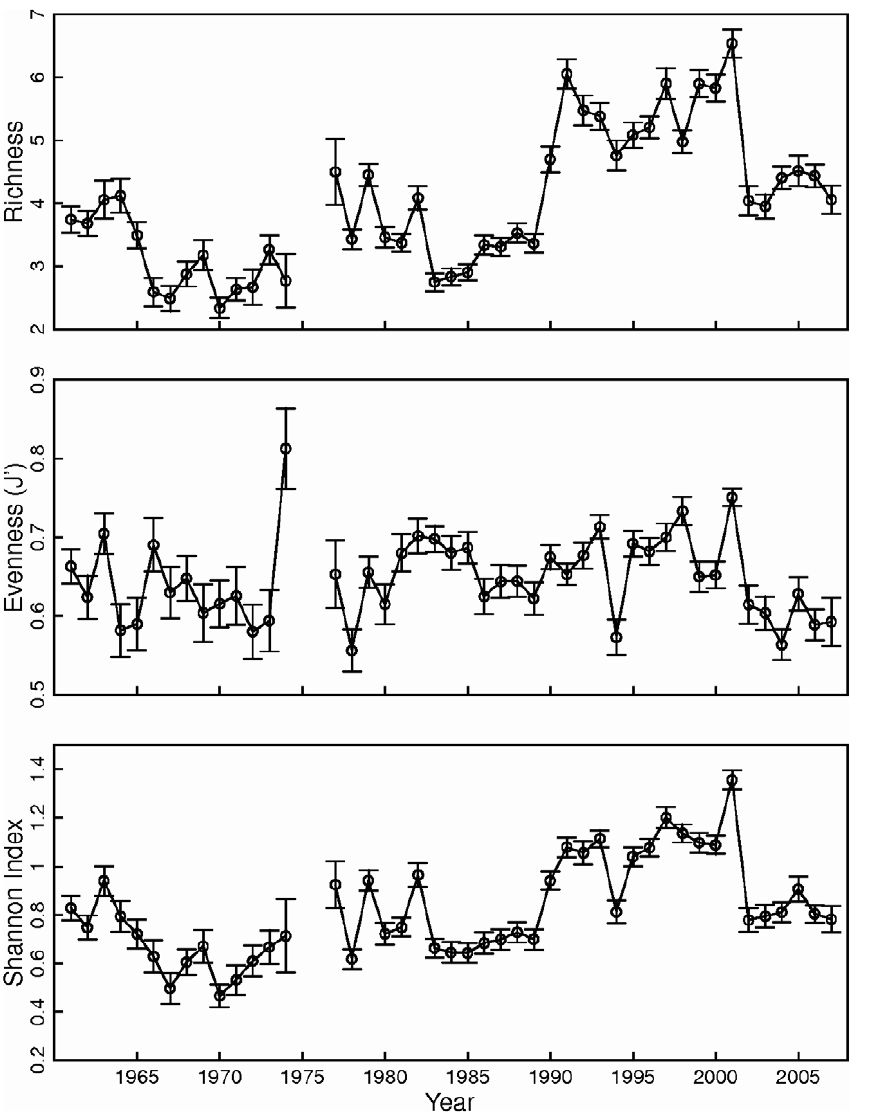
Figure 7. Interannual variation in copepod species richness, evenness, and diversity in the Gulf of Maine. Richness, evenness, and diversity were based on standardized Continuous Plankton Recorder samples. Bars indicate standard error. Mean sample size =94, s.d.=38.